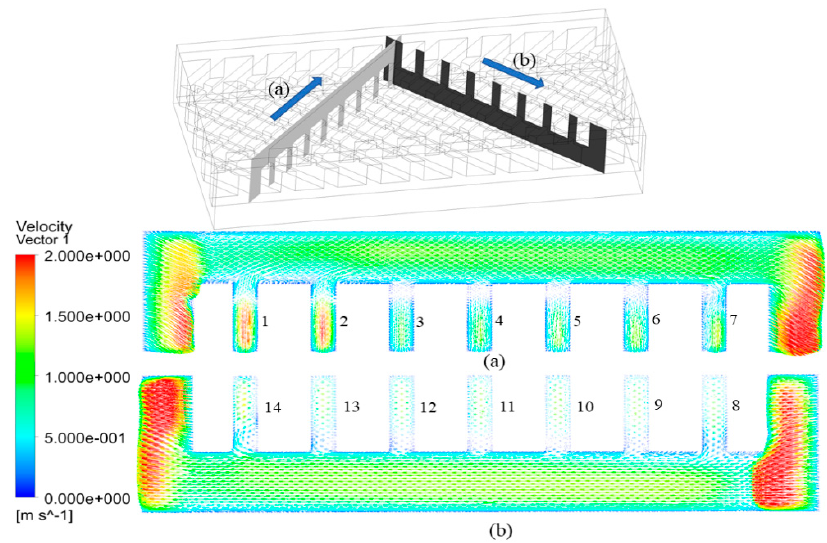
Figure 15. Velocity vectors on the mid-span sections of ( a ) top layer subchannel and ( b ) bottom layer subchannel in the DL-IM channel when Re = 132.